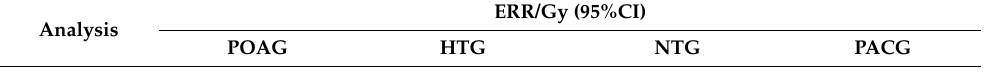
Table 5. Excess relative risks various primary glaucoma type incidence in relation to cumulative brain absorbed dose of external gamma-ray exposure lagged for 5 years—modification